Question: Give a one-sentence summary of this figure.
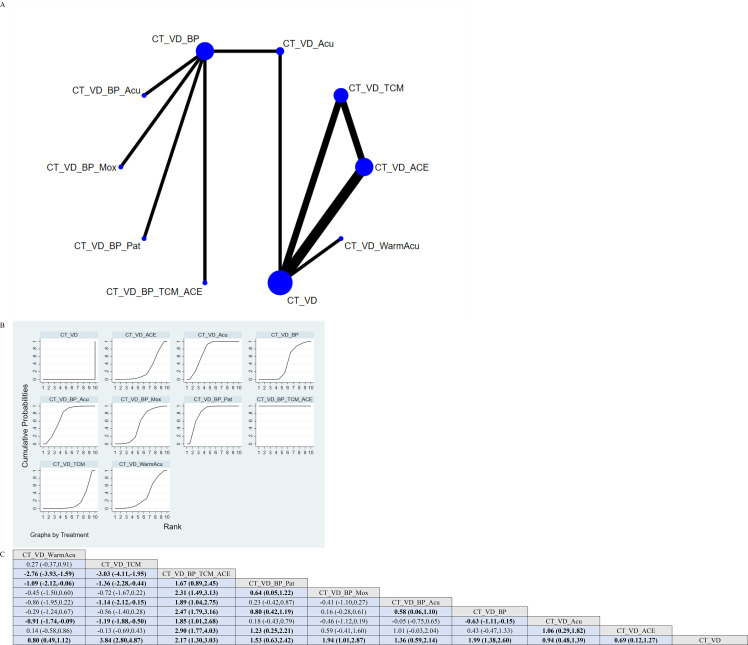
Answer: Network meta-analysis of E2 (A) Network plot of the network meta-analysis for E2. (B) Rankogram of overall intervention strategies from the network meta-analysis for E2. (C) League table of the network meta-analysis for E2.